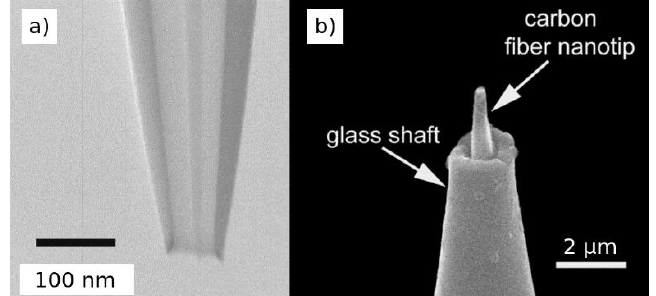
Figure 1. Electron microscopy images of ( a ) a quartz nanopipette and ( b ) a nanoelectrode fabricated with a carbon fiber and pulling of a glass pipette. Adapted with permission from [46,47] Copyright 2016 American Chemical Society and 2014 John Wiley and Sons.